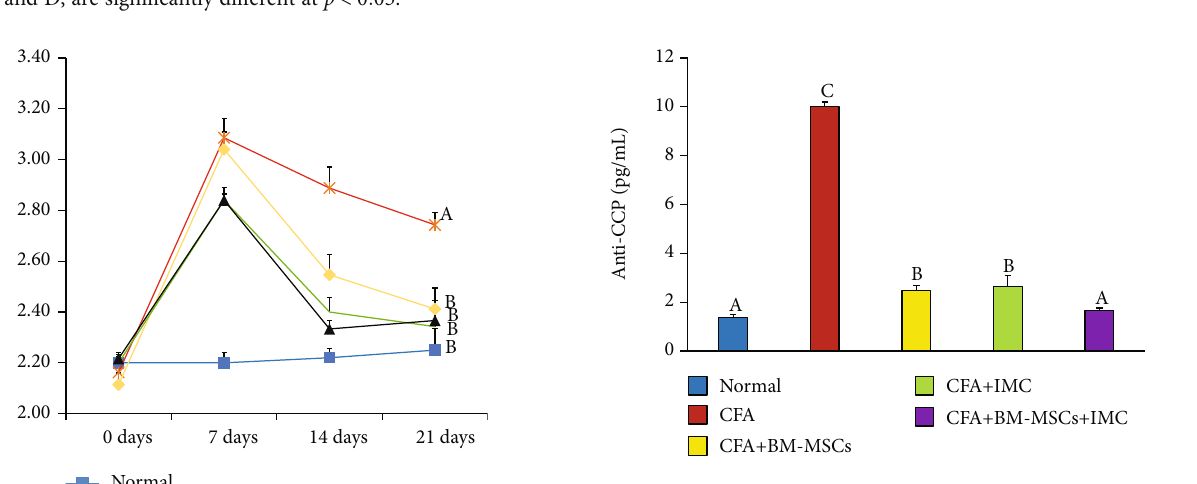
Figure 3: E ff ect of BM-MSCs and/or IMC on anti-CCP concentration in CFA-induced rats. Means, which have di ff erent symbols, A, B, and C, are signi fi cantly di ff erent at p < 0 : 05